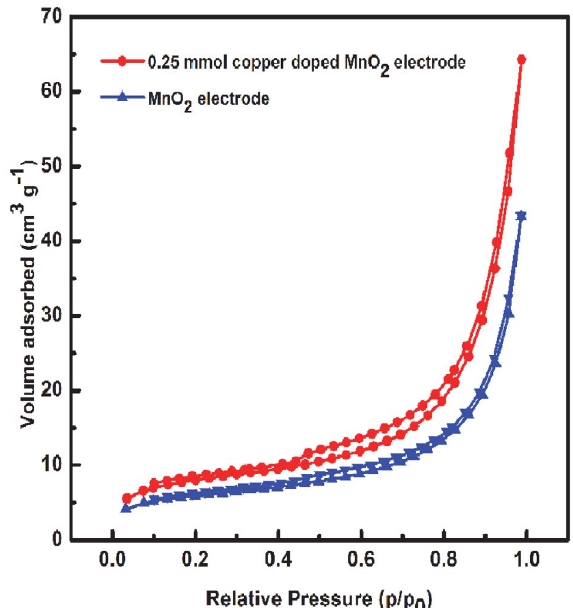
Fig. 3. Nitrogen adsorption-desorption isotherms of MnO 2 and 0.25 mmol Cu 2+ doped MnO 2